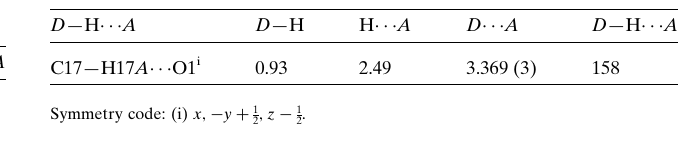
Table 2 Hydrogen-bond geometry (A˚ , (cid:3) ) for